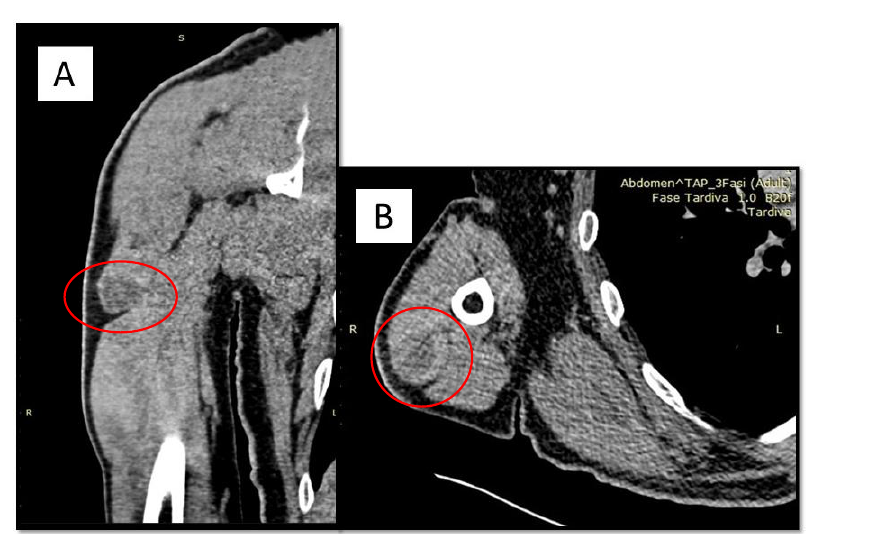
Figure 1. ( A , B ) CT findings of oval formation (red circle), 36 × 27 mm of diameter, in the lateral belly of the triceps brachial, located in the proximal third of the muscle, capsulated and well-defined in the surrounding muscle, except for minimal irregularities of the antero-lateral side. A 62-year-old man presented himself to the referral doctor in 2018 for unspecified pain in his left arm. After an